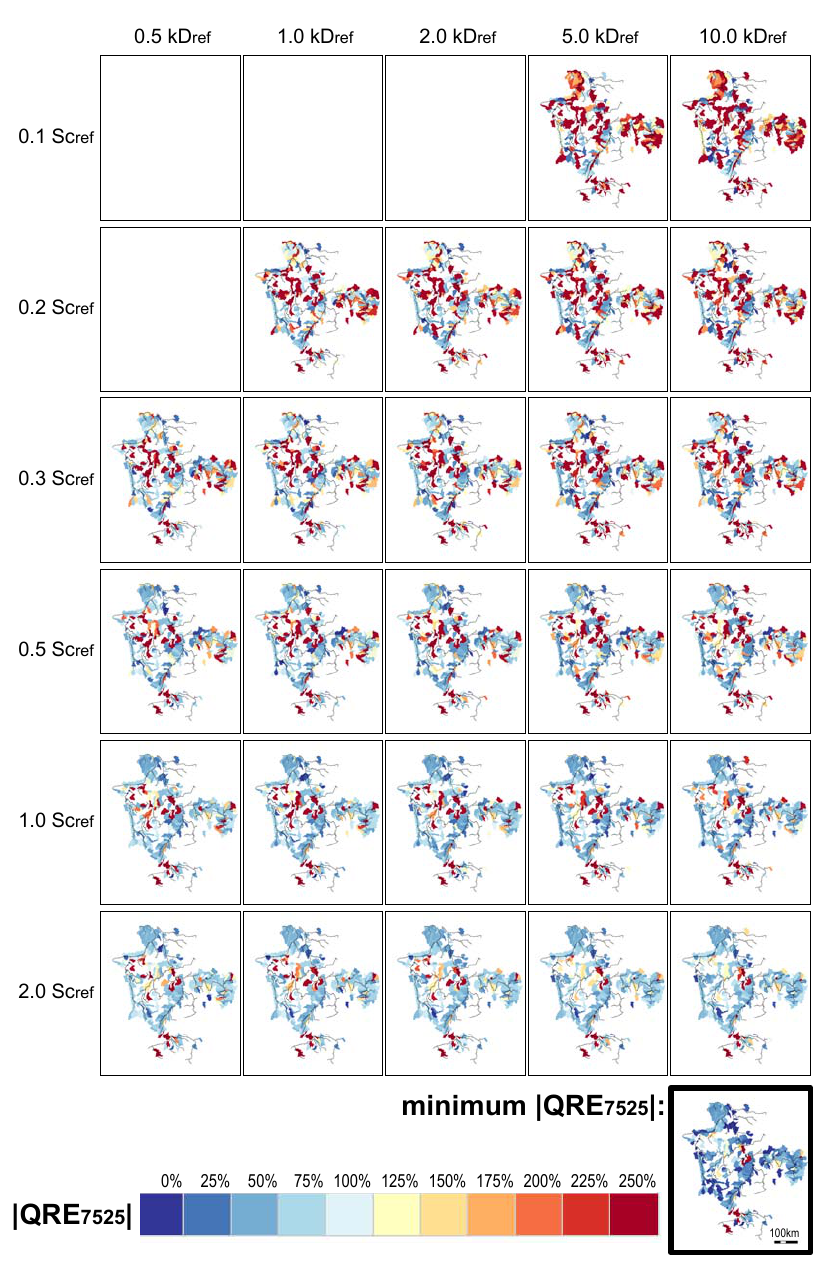
(cid:12) (cid:12) (cid:12) QRE 7525 (cid:12) , for all scenarios. The lower right corner map is a composite map